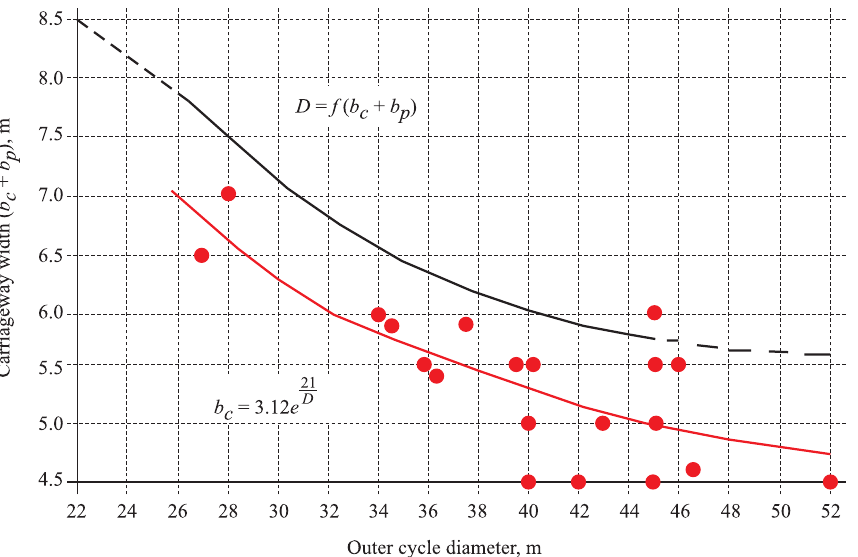
Fig. 4. Relationship between the carriageway width (including a paved part) and the outer cycle diameter: